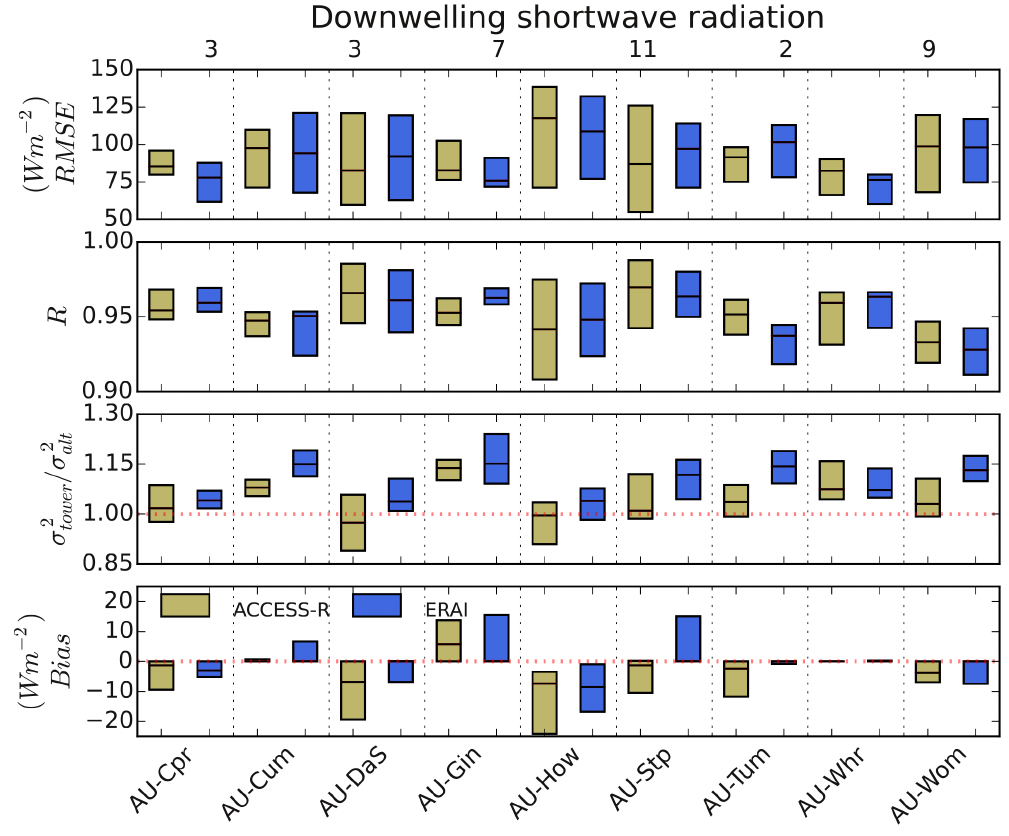
Figure 4. Box plot of bias, variance ratio, correlation coefficient and root mean square error for the comparison of tower and alternate incoming short wave radiation at nine OzFlux sites. Statistics for ACCESS-R are plotted in khaki and ERA-Interim in blue. Box lengths represent the 75 and 25% quartiles and the median is plotted as a solid line across the boxes. Numbers at the top are the percentage of missing data that are gap